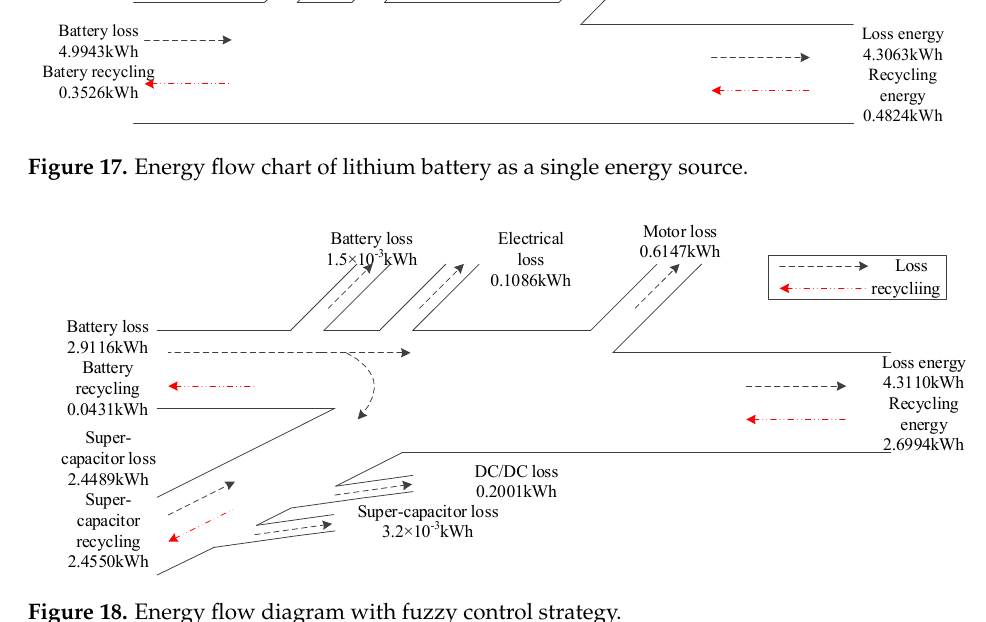
Figure 18. Energy flow diagram with fuzzy control strategy.